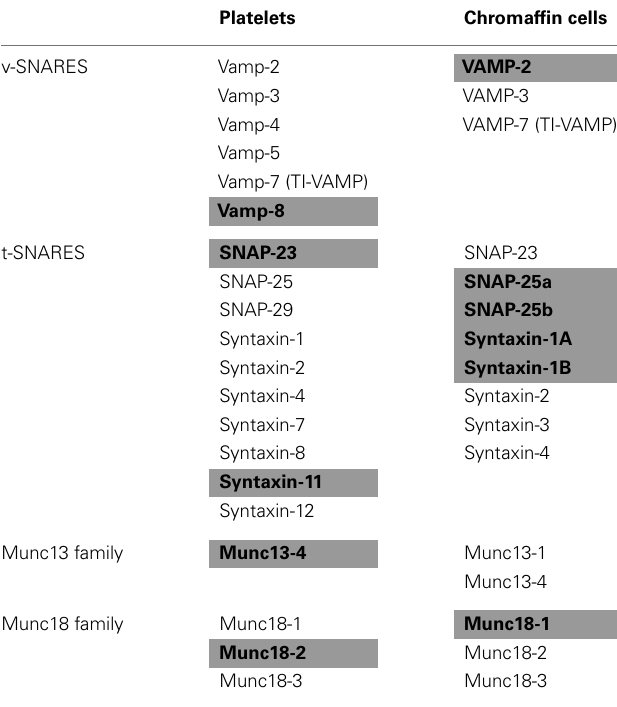
Table 3 | SNAREs and SM proteins in platelets and chromaffin